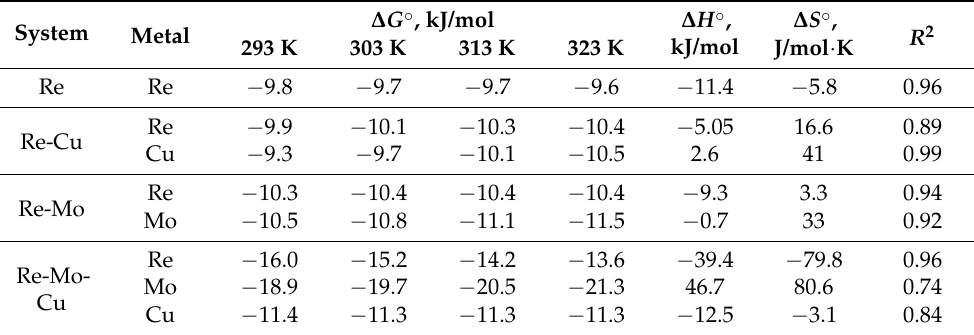
Table 1. Thermodynamic parameters of metal ions biosorption on yeast biomass.